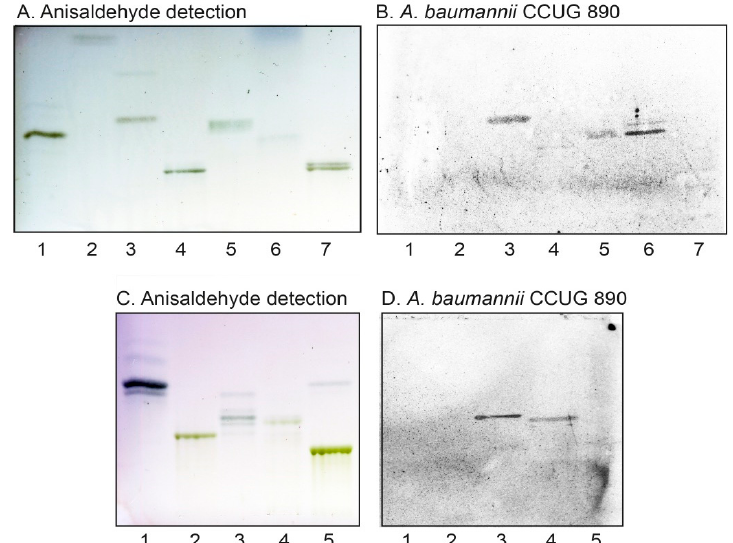
Figure 2. A. baumannii binding glycosphingolipids isolated from rabbit small intestine (fraction RI-4) and human small intestine (fraction HI-4). Chemical detection by anisaldehyde ( A,C ),